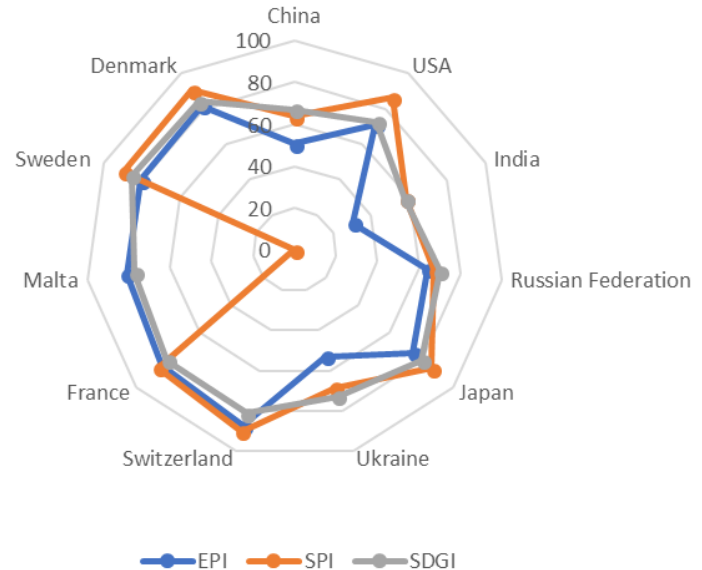
Figure 5. Comparison analysis of EPI, social progress index and SDG Index score by countries